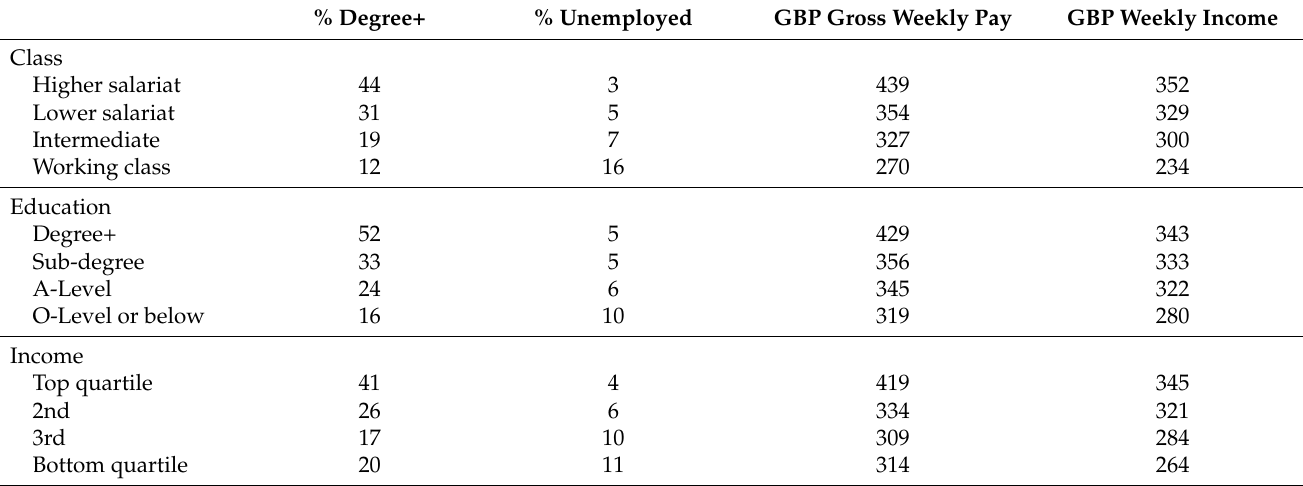
Table 3. Selected characteristics of educational attainment and labour position by family